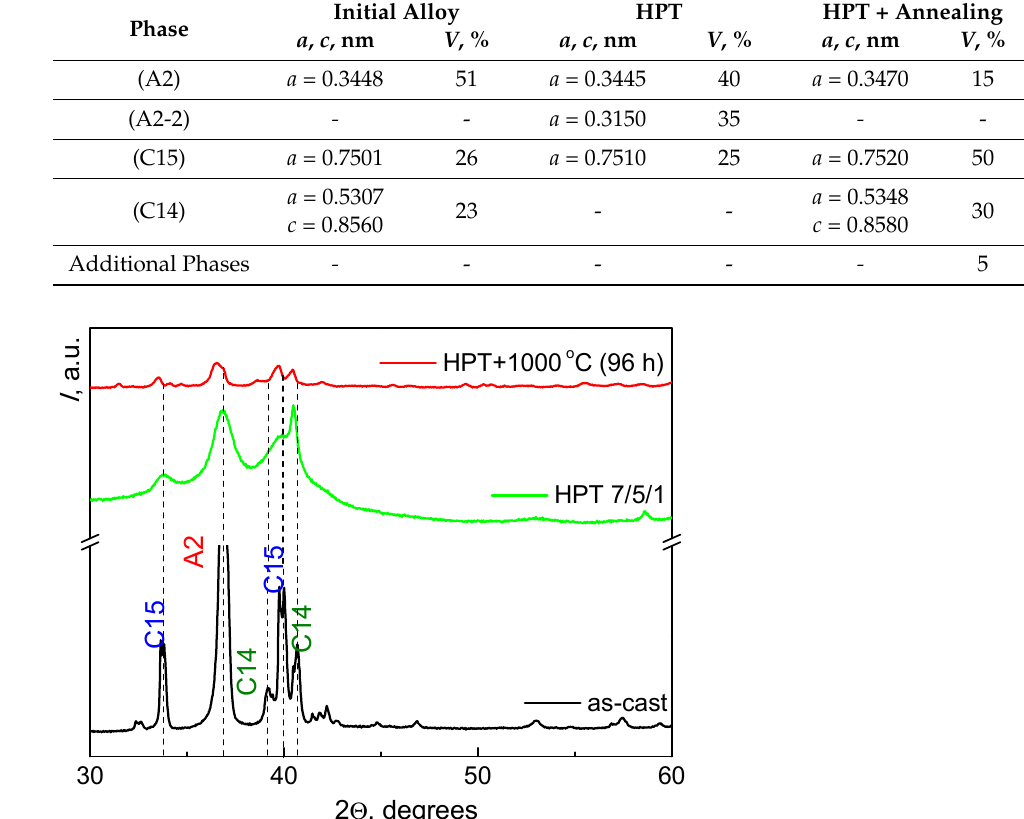
( b ) Figure 9. SEM images of the microstructure of the TiZrHfMoCrCo alloy ( a ) the as-cast sample subjected to HPT, ( b ) HPT plus additional annealing at 1000 °C 96 h.